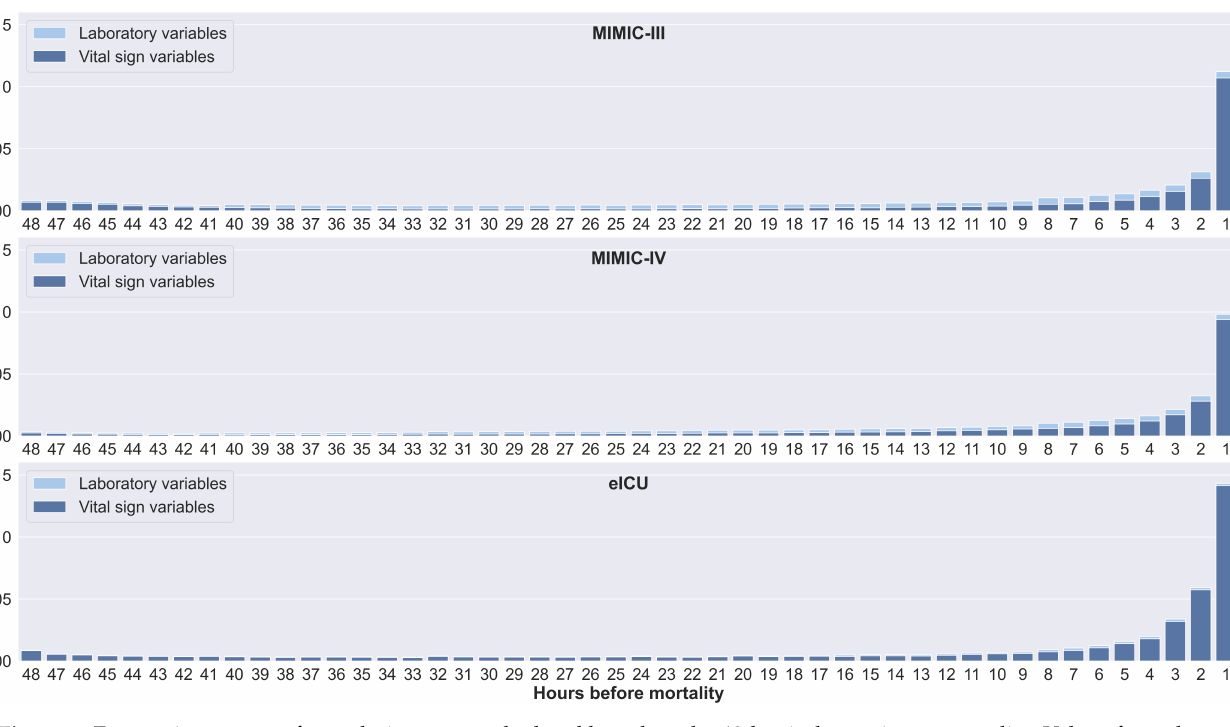
Figure 6. Feature importance for each time step, calculated based on the 48-h window prior to mortality. Values from the time steps preceding the mortality event have a large impact on the prediction. The values of vital signs from the earliest time steps were also observed to impact the